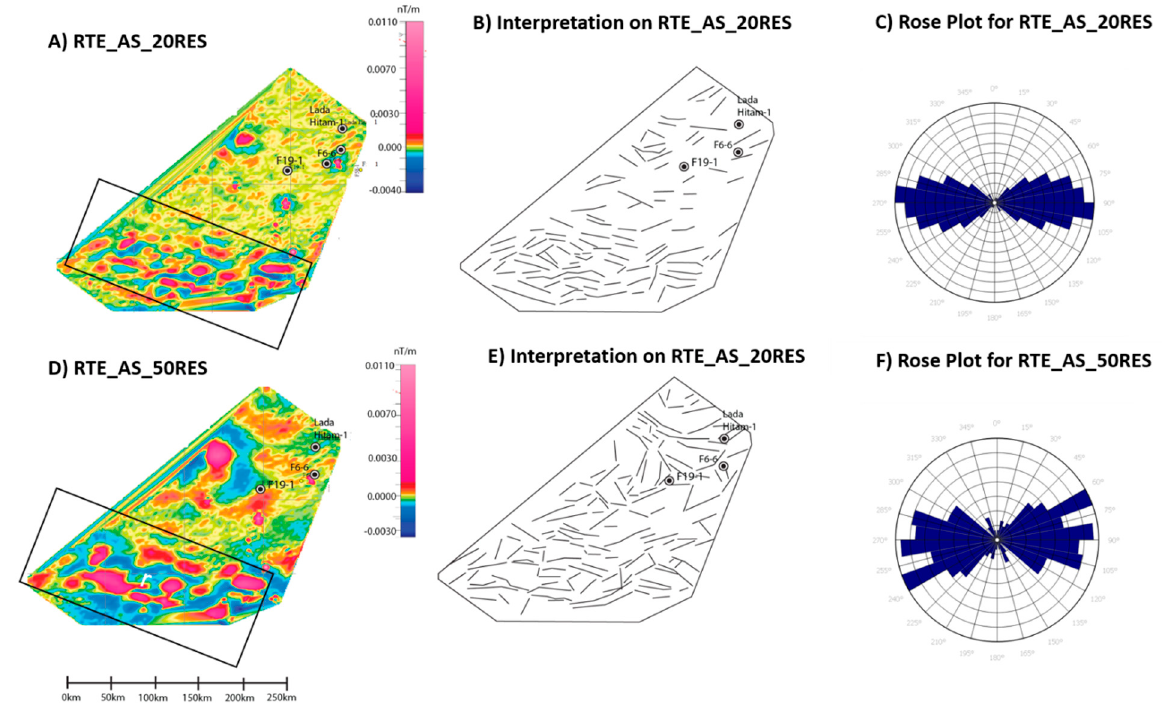
Figure 7. This figure highlights the interpretation on residual analytical signal of original aeromagnetic data from TMI_RTE. ( A ) Analytical signal (Residual) for >20 km wavelength. ( B ) The interpretation of structural trend based on ( A ). ( C ) Rose plot diagram for interpreted structural trend in B, showing distinct E-W direction. ( D ) Analytical signal (Residual) for >50 km wavelength. ( E ) The interpretation of structural trend based on ( D ). ( F ) Rose plot diagram for interpreted structural trend in ( E ), showing NE-SW, E-W and NW-SE directions. Table 2. Major and minor structural trends recorded from aeromagnetic and airborne gravity data in Central Luco- nia